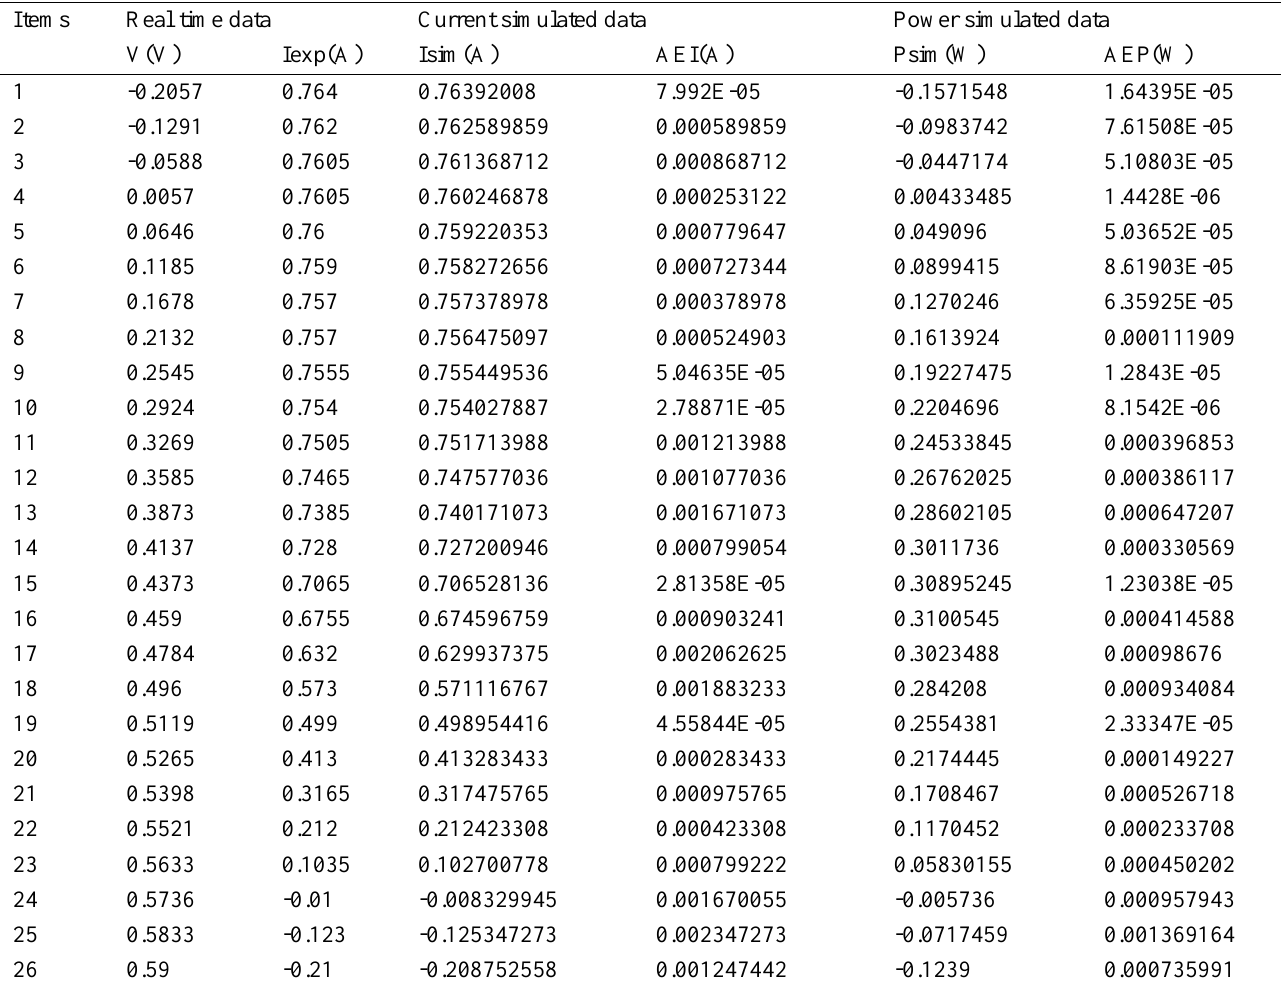
Absolute Error (AE) of Double Diode Model at the best Root Mean Square Error using